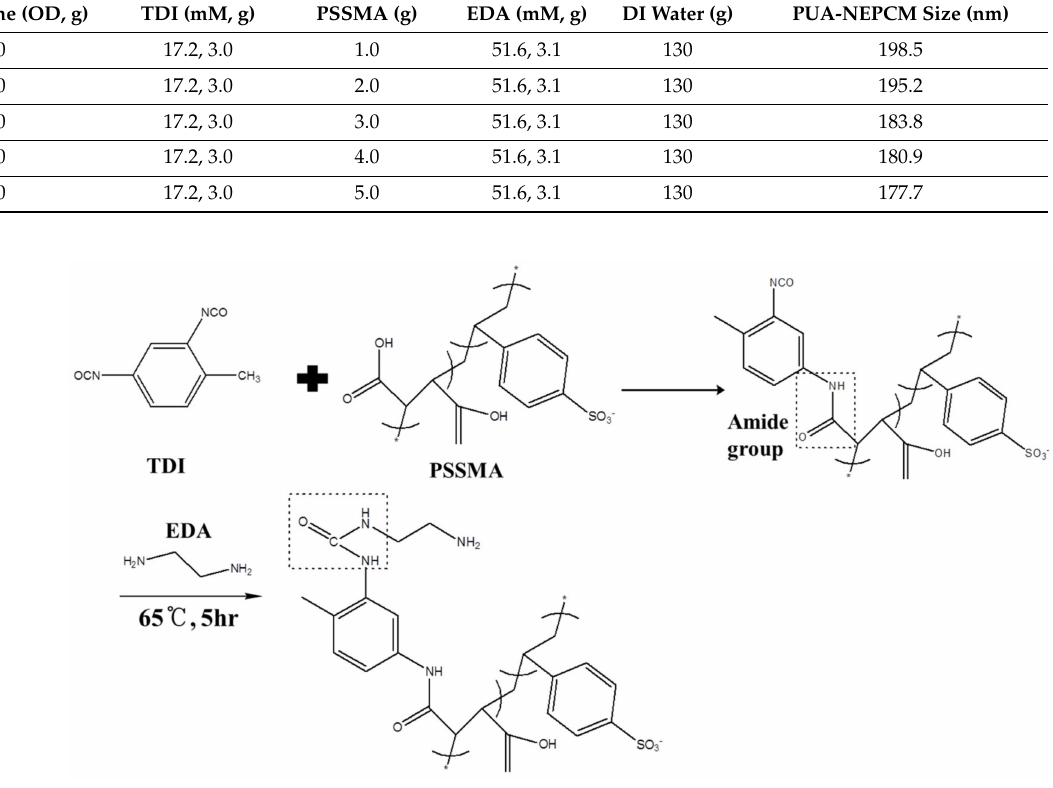
Figure 1. Synthetic mechanism to obtain